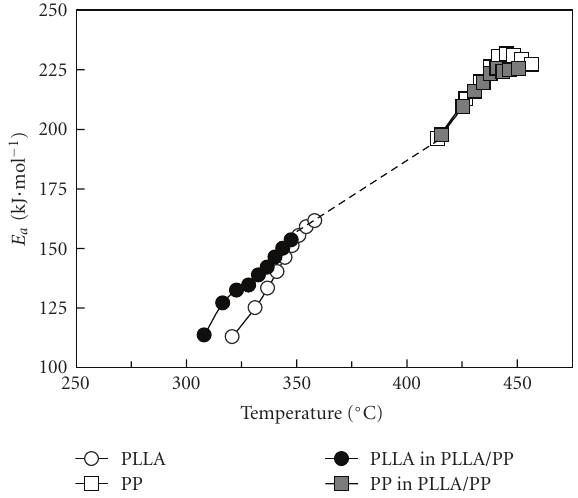
Figure 6: Activation energy, E a , plots against temperature for thermal degradation of PLLA, PP, and PLLA/PP blend. ϕ = 5 ◦ Cmin − 1